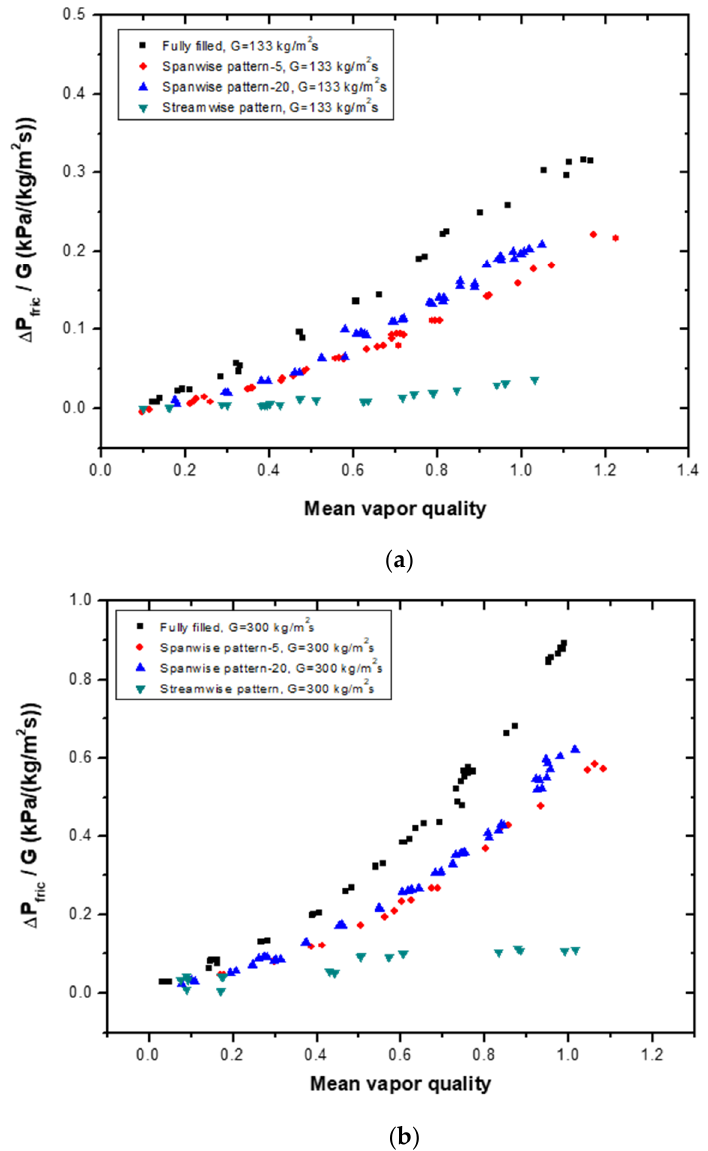
Figure 8. Comparison of the two-phase frictional pressure drop per unit mass flux at ( a ) G = 133 kg/m 2 s and ( b ) G = 200 kg/m 2 s for different patterned models of porous media with a fully filled porous media channel.